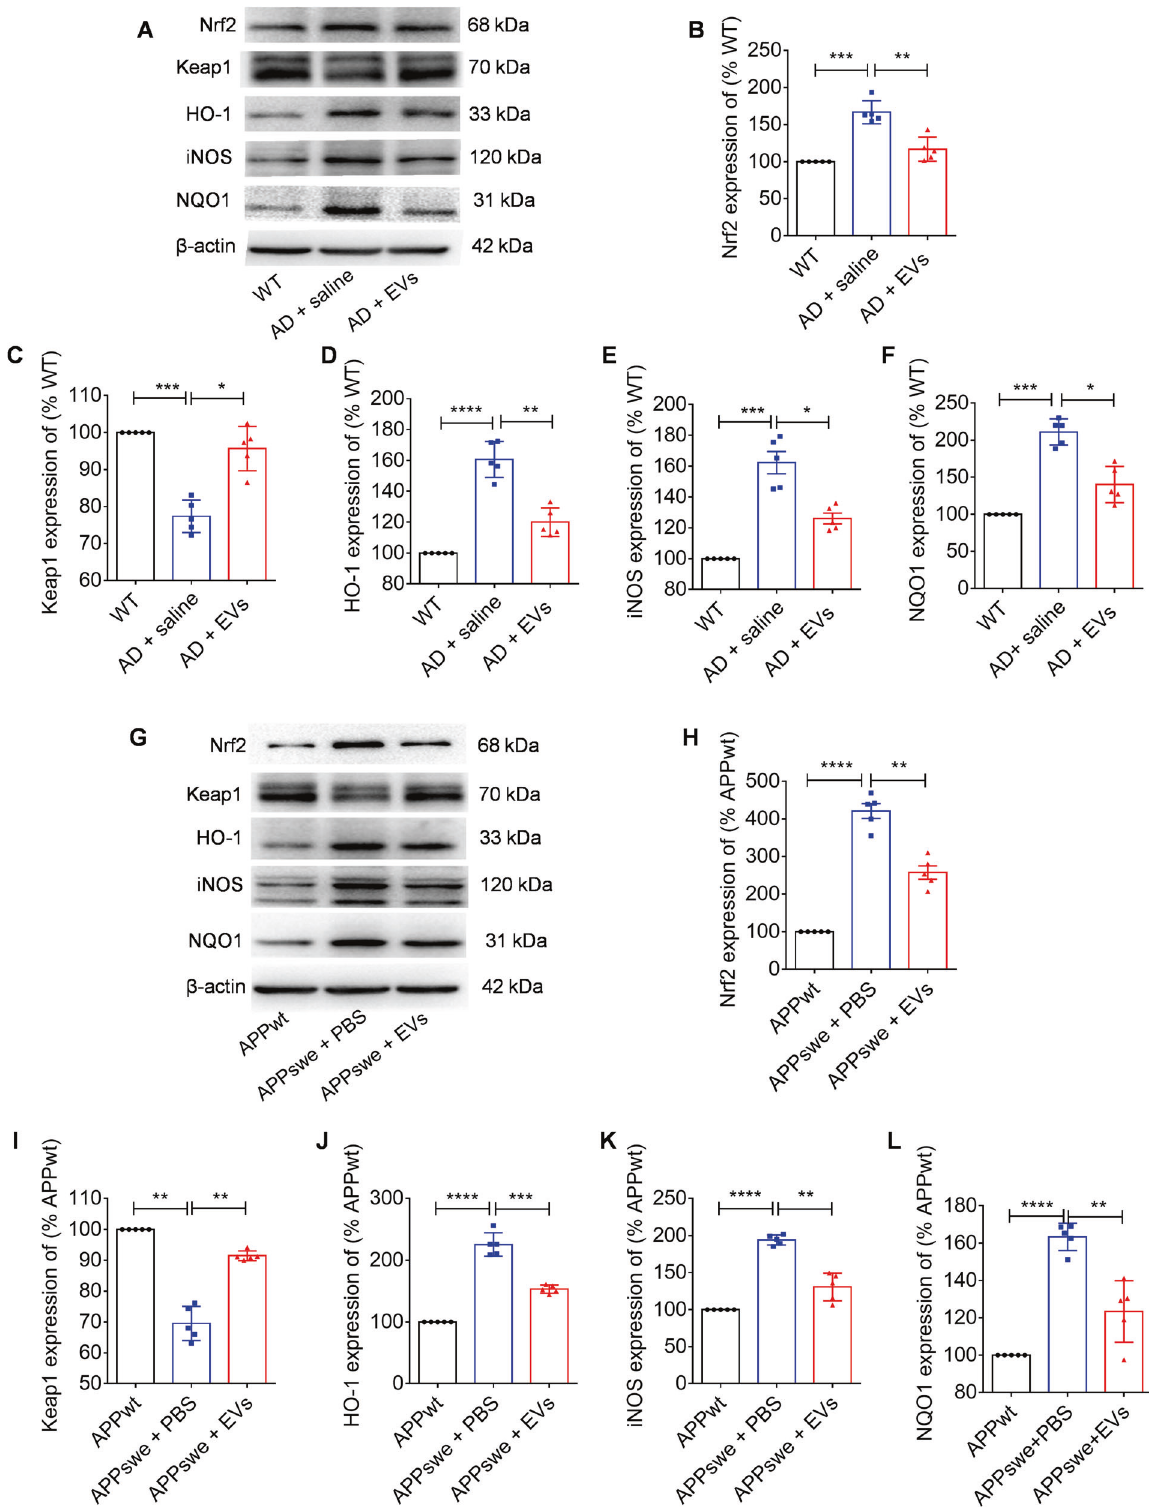
Fig. 6 Oxidative defense system is associated with the EVs therapy in APP/PS1 mice. A Western blots of nuclear factor E2-related factor 2 (Nrf2) signaling and oxidative marker inducible nitric-oxide synthase (iNOS) in the animal models. B – F Statistical analysis of the relative expression of Nrf2 ( B ), Keap1 ( C ), HO-1 ( D ), iNOS ( E ), and NQO1 ( F ) in the WT, AD + saline, and AD + EVs groups mice ( n = 5 per group). G Western blots of Nrf2 signaling and iNOS in APPwt, APPswe + PBS, and APPswe + EVs groups. H – L Statistical analysis of the relative expression of Nrf2 ( H ), Keap1 ( I ), HO-1 ( J ), iNOS ( K ), and NQO1 ( L ) in cell models. The values represent Mean ± SEM. The data meet normal distribution and the variance is homogeneous. * P < 0.05, ** P < 0.01, *** P < 0.001, **** P < 0.0001.